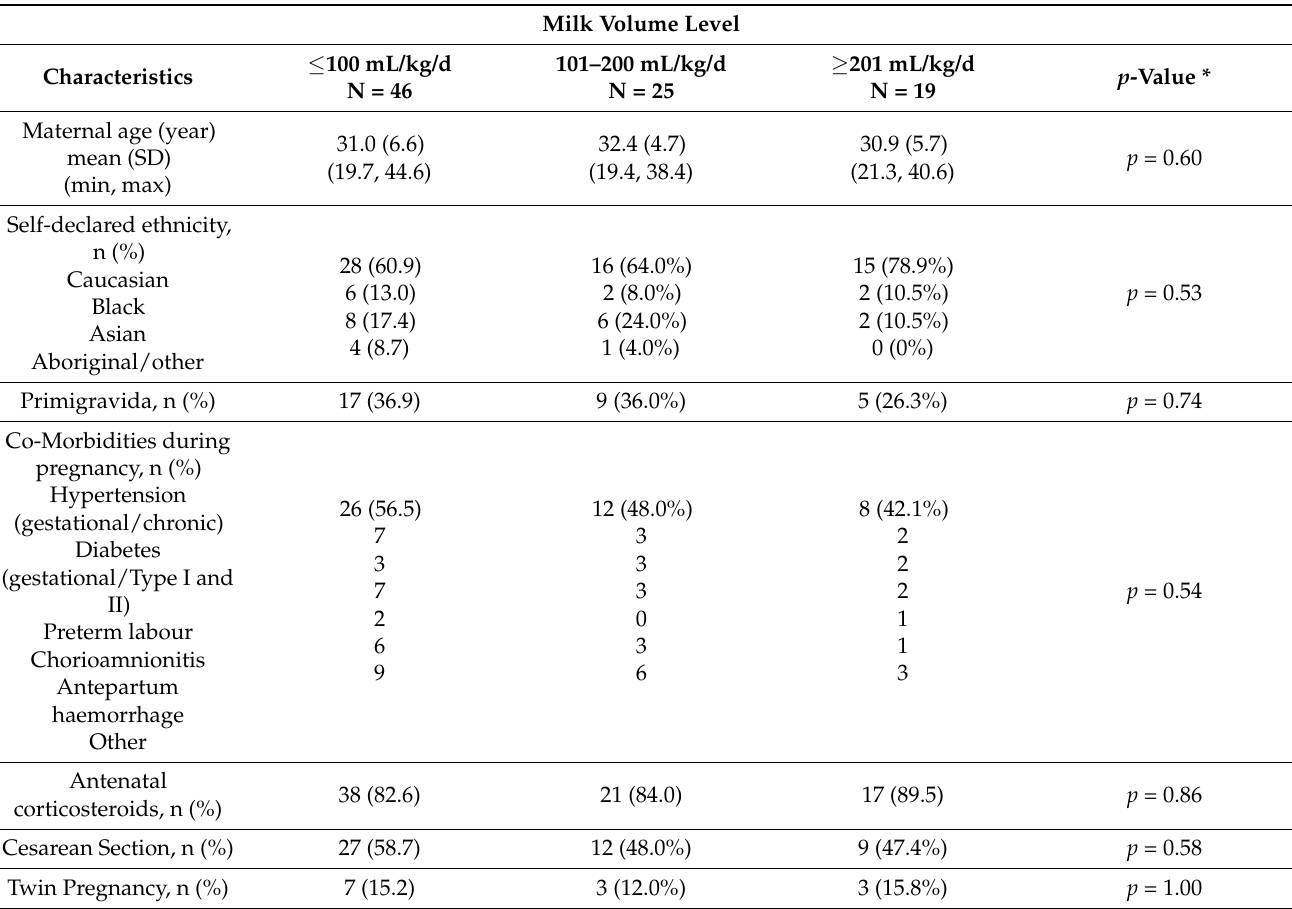
Table 1. Baseline characteristics of mothers. Milk Volume